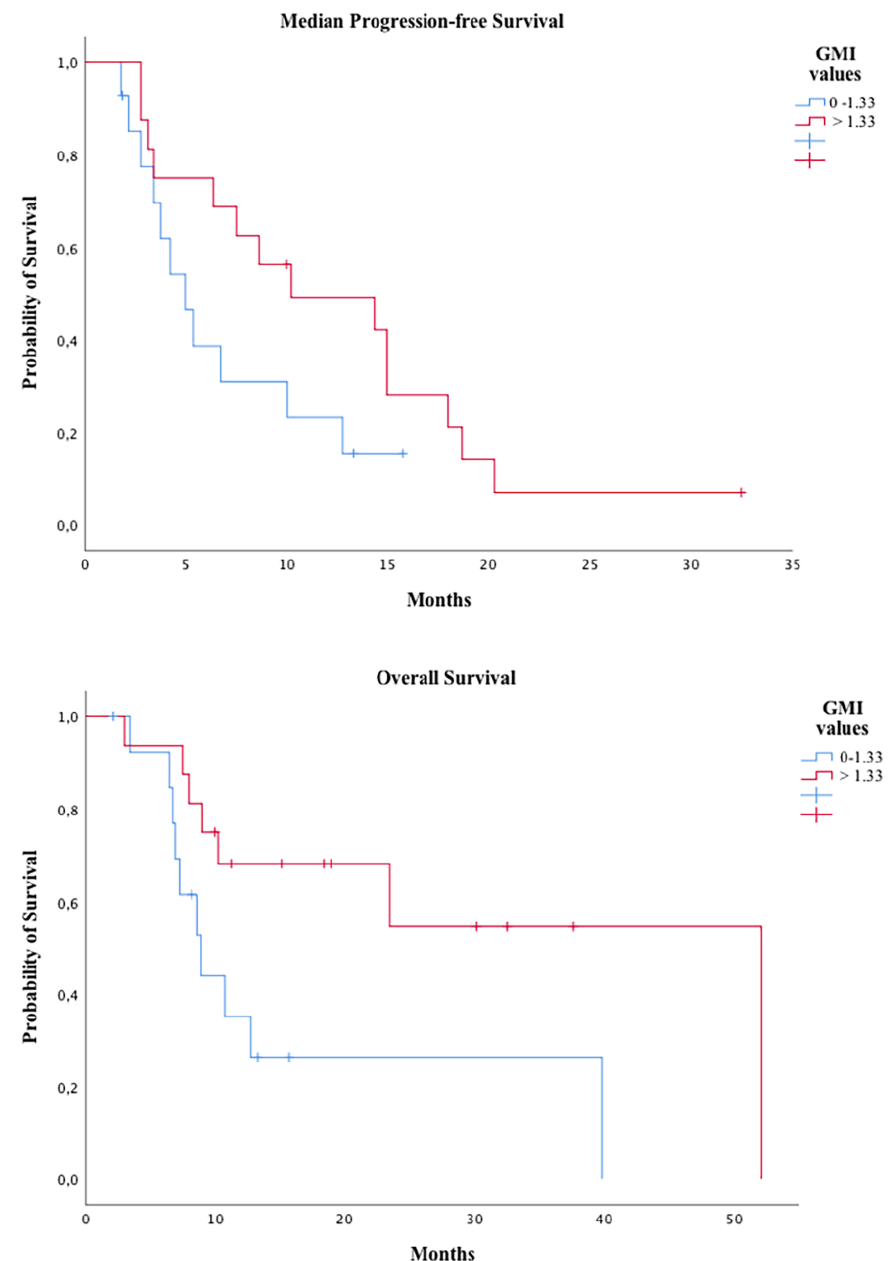
Figure 4. Progression-free survival and overall survival for trabectedin according to growth-modulation index (GMI).